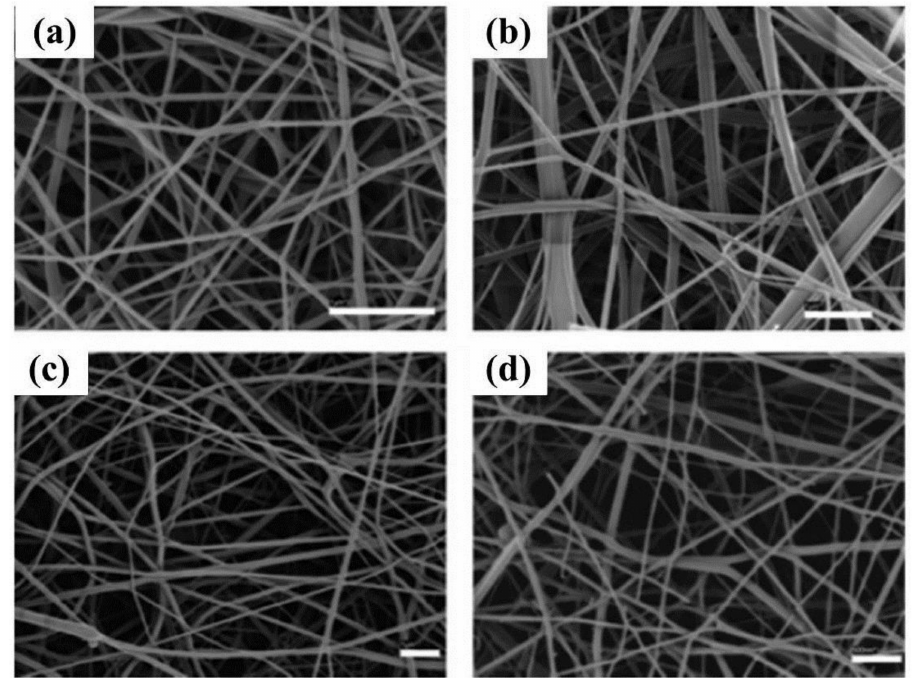
Figure 10. SEM images of electrospun chitosan fibers: ( a ) Low MW; ( b ) medium MW; ( c ) high MW; and ( d ) practical grade. The scale bars in all the images are 1 µ m, except in ( d ), where the scale bar indicates 500 nm. Reproduced with permission from ref. [160]. Copyright American Chemical Society,